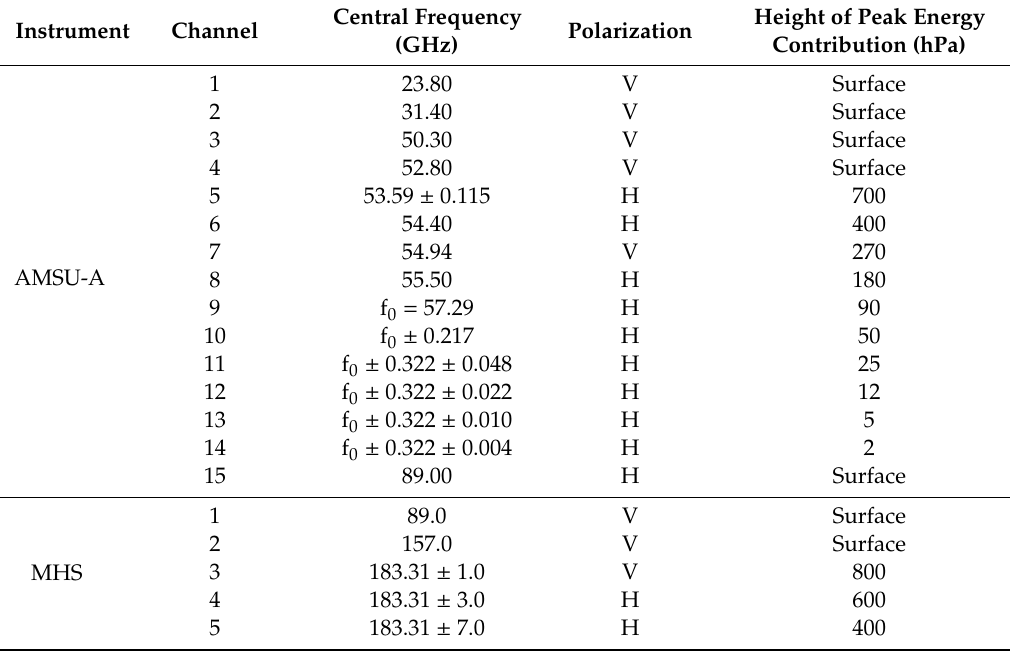
Table 1. AMSU-A and MHS channel